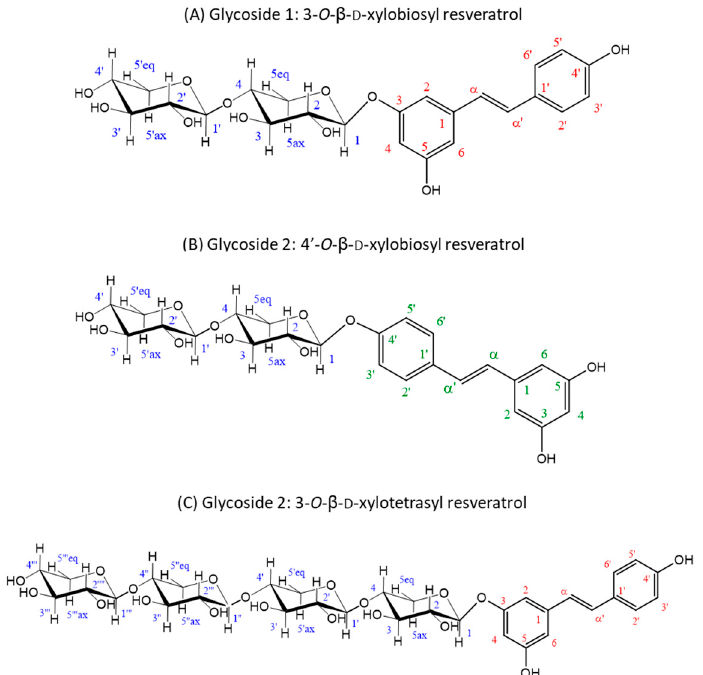
Figure 3. Structures deduced from NMR analysis of the purified glycosides 1 and 2 . ( A ) Glycoside 1 is the major product of the glycosylation reaction and was identified as 3- O - β - D -xylobiosyl resveratrol. ( B , C ) Glycoside 2 contains a mixture of minor reaction products resulting from the glycosylation of resveratrol, identified as 4 (cid:48) - O - β - D -xylobiosyl resveratrol ( B ) and 3- O - β - D -xylotetraosyl resveratrol ( C ) in a 3:1 ratio. Every C atom and associated proton in the molecules are numbered to clarify the identification of the signals (xylobiose C atoms are represented in blue, resveratrol C atoms of 3- O - β - D -xylobiosyl resveratrol and 3- O - β - D -xylotetraosyl resveratrol in red and resveratrol C atoms of 4 (cid:48) - O - β - D -xylobiosyl resveratrol in green) in the NMR spectra (Figures S2 and